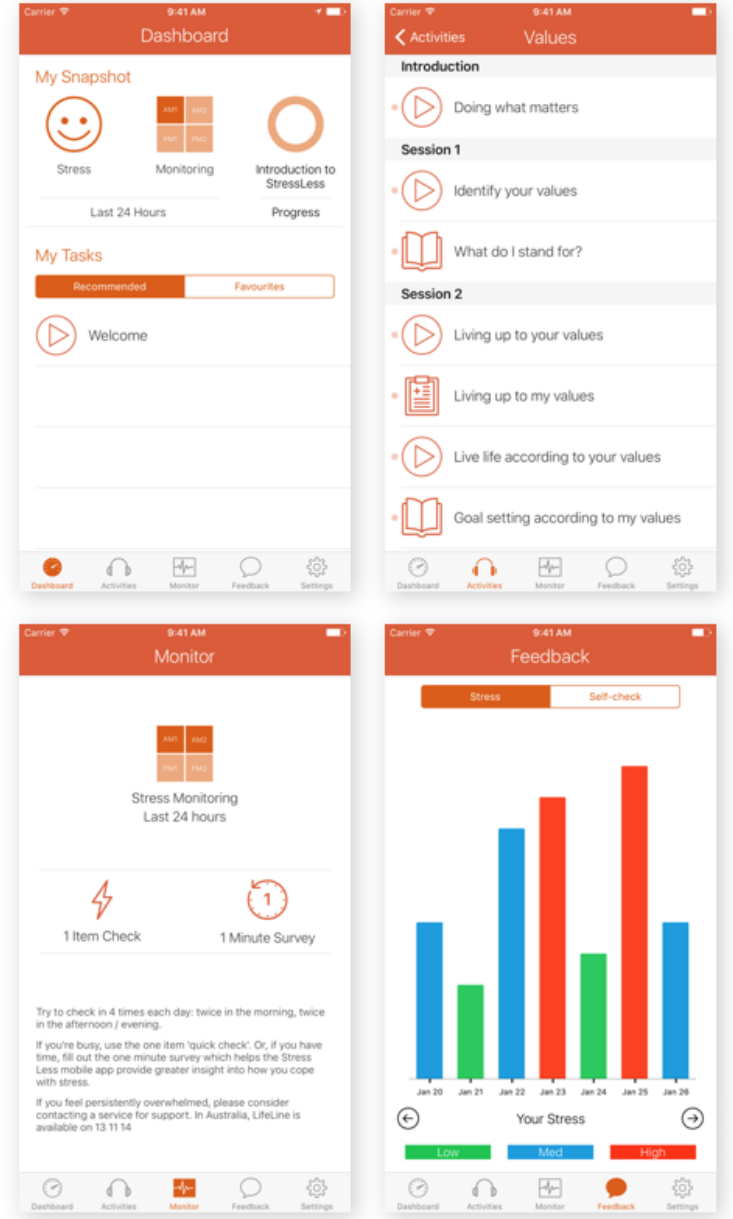
Figure 2. This figure shows layout of the